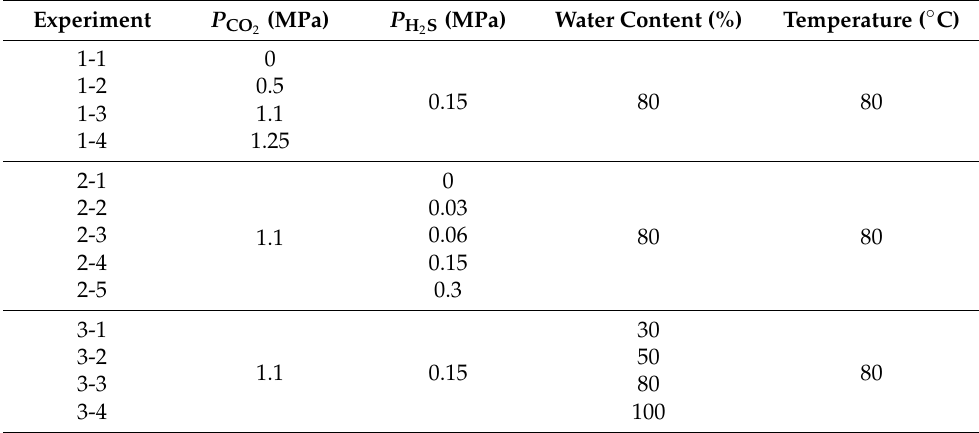
Table 3. Test conditions of polarization measurement.